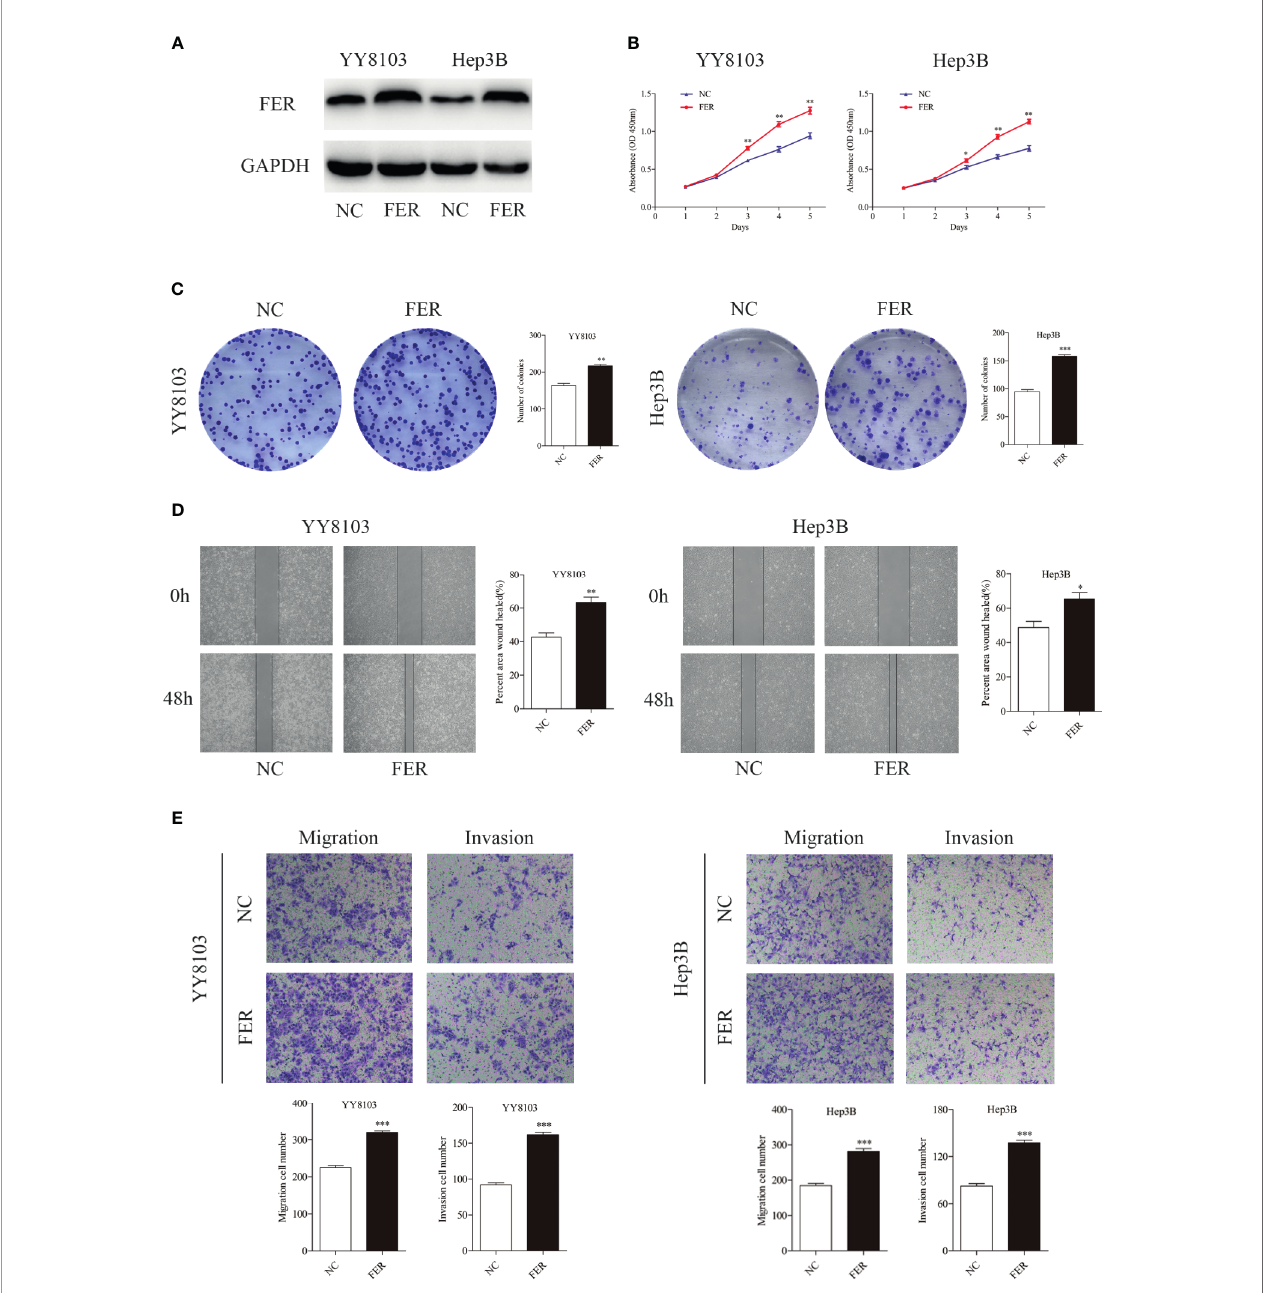
FIGURE 3 | Upregulation of FER augments cell growth and metastasis in vitro . (A) FER expression levels were explored in YY8103 and Hep3B cells transfected with FER overexpression lentivirus. (B) CCK-8 assay results of YY8103 and Hep3B cells. (C) Colony formation assay results of YY8103 and Hep3B cells overexpressing FER. (D) Wound healing assay suggested that upregulation of FER increased motility in YY8103 and Hep3B cell lines. (E) Transwell assays demonstrated that HCC cells overexpressing FER showed increased cell invasion and migration. (*P < 0.05, **P < 0.01, ***P <